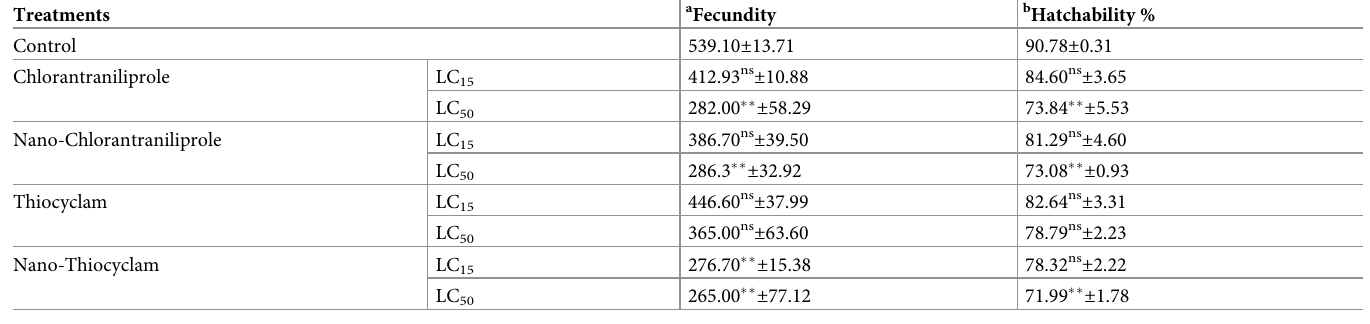
Table 4. Mean fecundity and hatchability % ( ± SE) of A . ipsilon females after treating the 2 nd instar larvae with LC 15 and LC 50 values of chlorantraniliprole, thiocy- clam, and their nano-form. Treatments